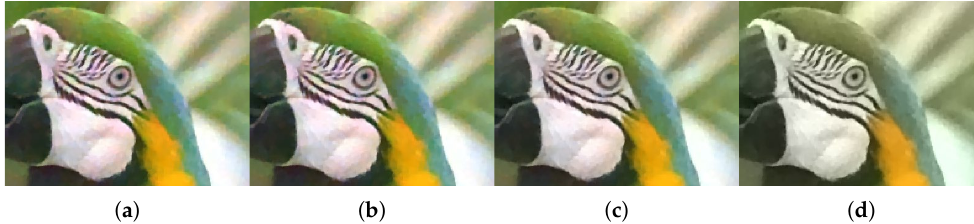
Figure 10. Influence of regularization parameter λ 2 for test image Parrot for crosstalk degradation 2 (crosstalk kernel with σ g = 0.6 and noise with σ n = 0.04): ( a ) λ 2 = 0.0001, ( b ) λ 2 = 0.001, ( c ) λ 2 = 0.01, and ( d ) λ 2 = 0.1.